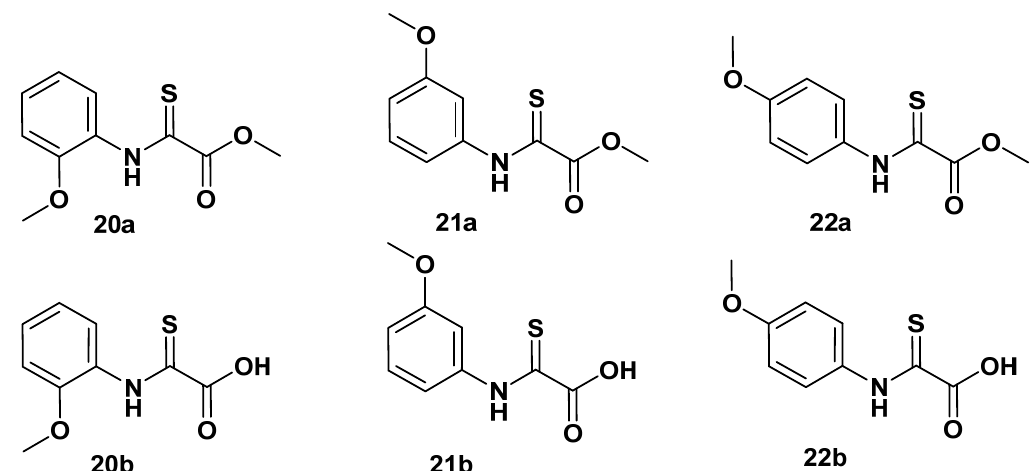
Figure 9. Selective exchange of 2-oxo function with the Lawesson reagent to 2-thio derivatives. Table 6. N -( o -, m -, p -methoxyphenyl)-2-thio oxalamic acid methyl esters ( 20a – 22a and the corre- sponding acids 21b – 22b . Data fit with GRAPHPAD PRISM 5. Standard error of the fit given in µ M. IC 50 diagrams, including the fit and standard deviations of the individual experiments ( n = 3), are depicted in the Supplementary Materials.